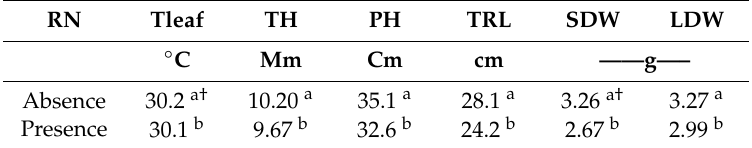
Table 9. Reniform nematode e ff ect on morphological and physiological parameters of cotton at 60 days after